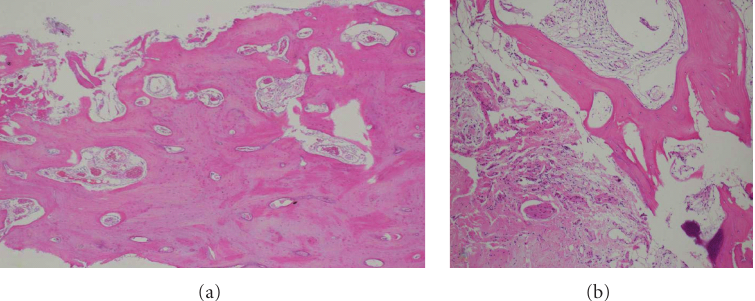
Figure 5: Photomicrograph from the proximal humerus biopsy shows (a) an area of trabecular bone that has been replaced with new vascular channels (hemangiomatous) as well as (b) fibrous tissue replacing the absorbed bone without evidence of regeneration of the bone matrix (hematoxylin & eosin stain, original magnification